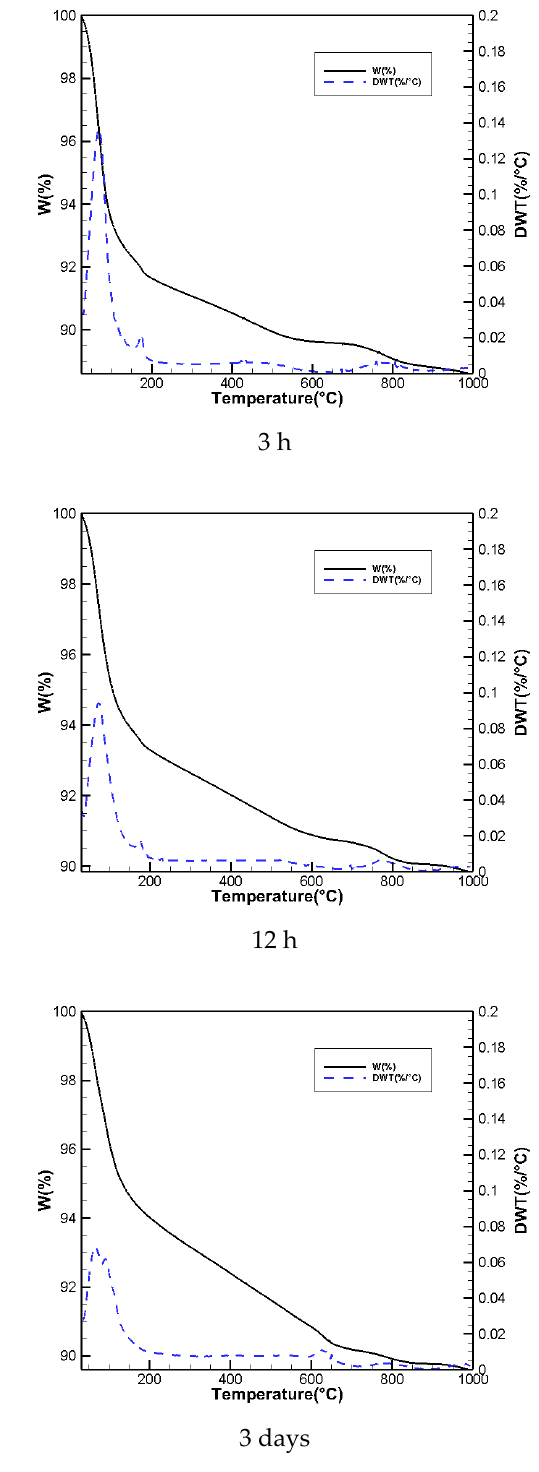
Figure 10. Thermogravimetric analysis results .